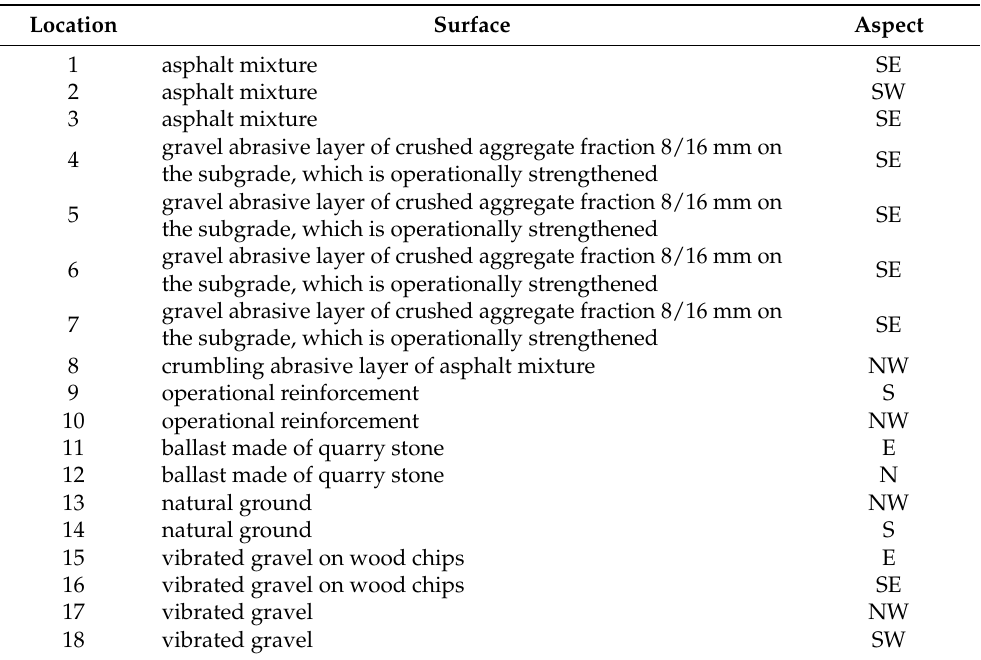
Figure 2. Distribution of measured locations in the area of interest, source [46,50]. Table 1. Types of measured surfaces.